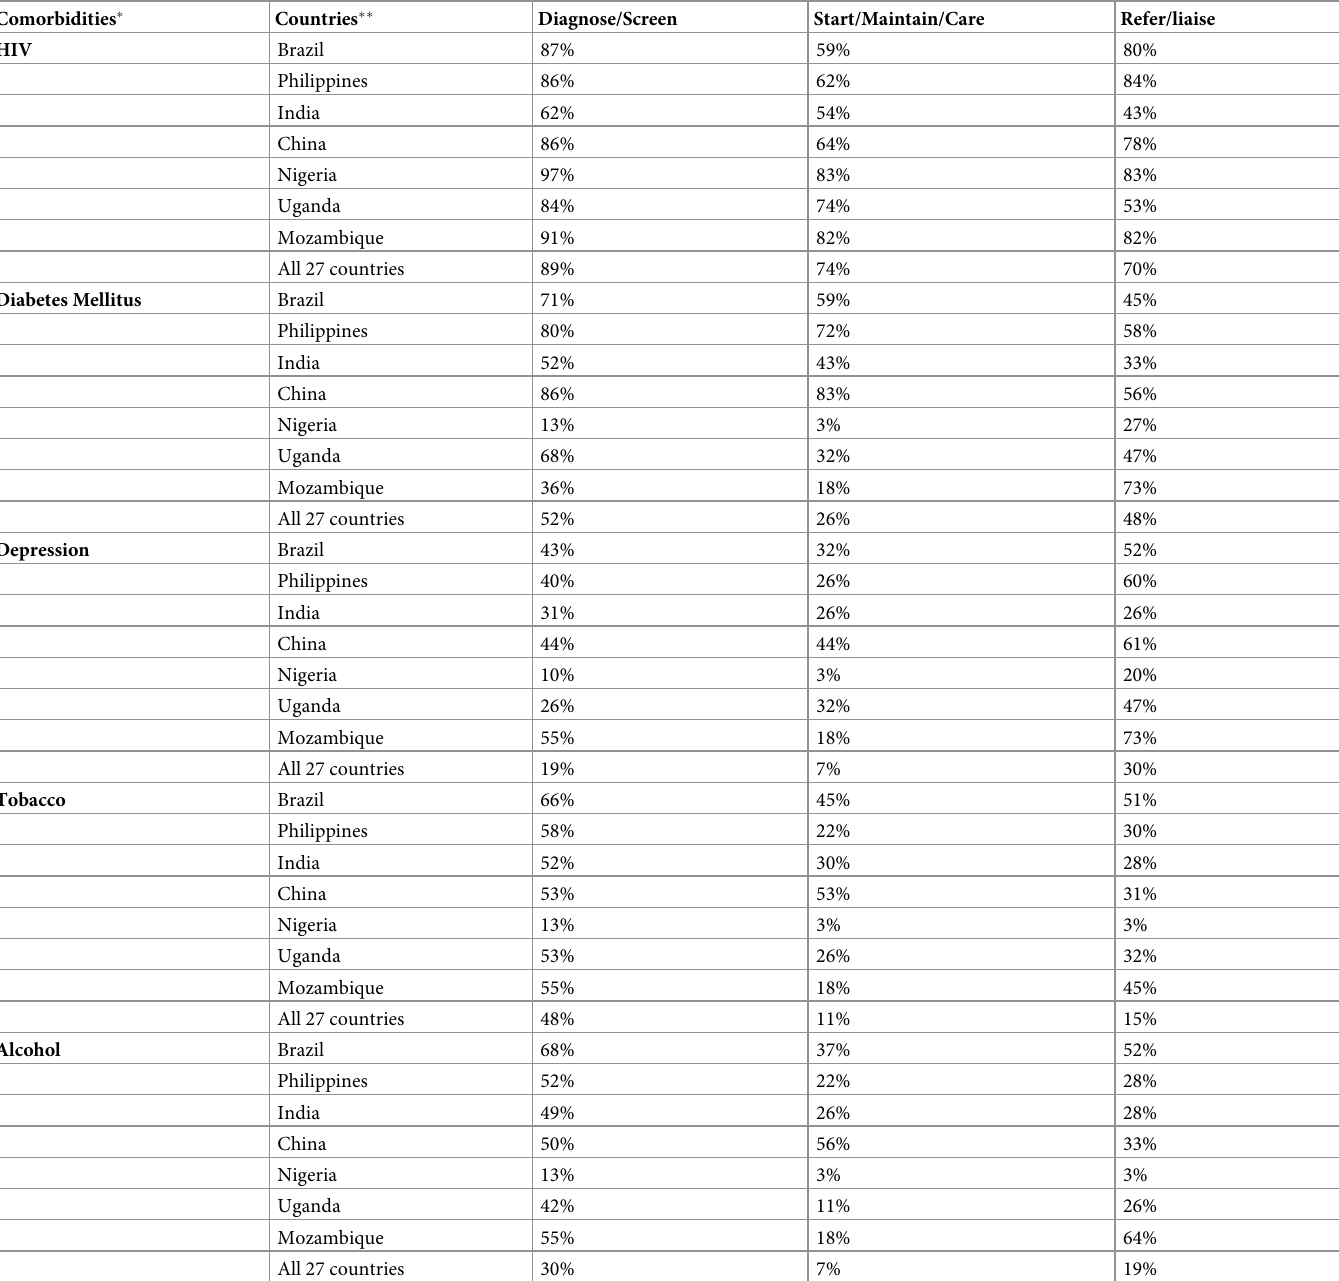
Table 3. Proportion of countries where majority ( > 50%) thought that specific comorbidities are managed within TB services. Comorbidities � Countries �� Diagnose/Screen Start/Maintain/Care Refer/liaise HIV